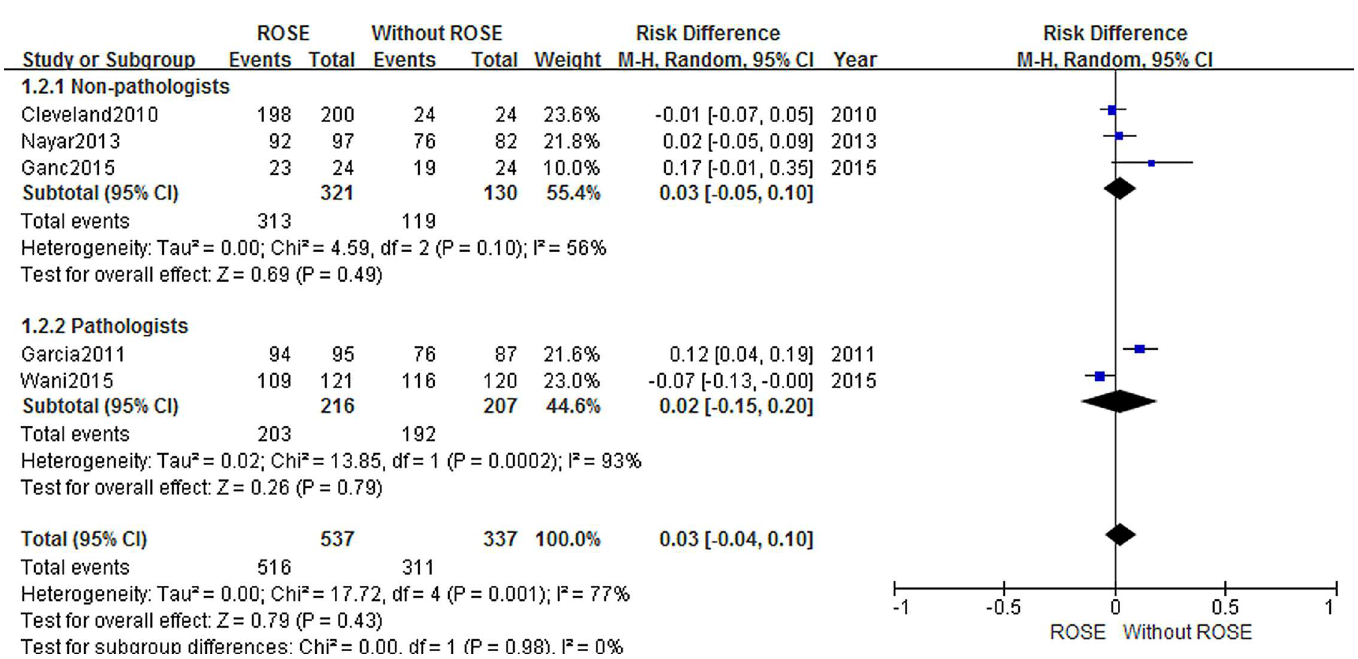
Fig 3. Forest plot displaying the impact of assessortype to adequacy rate.